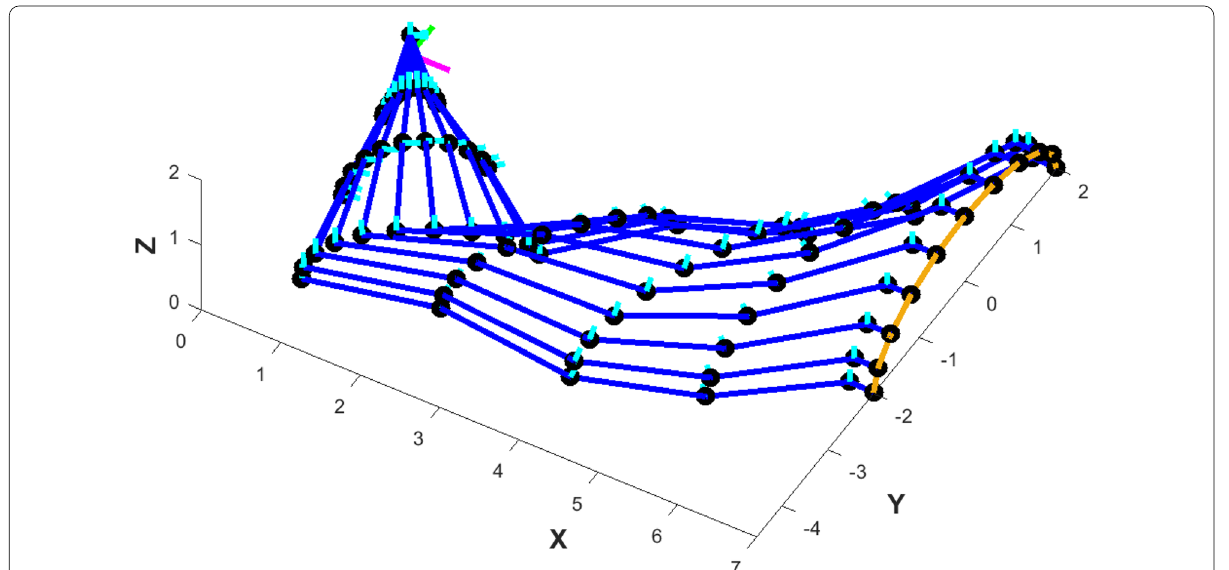
Fig. 9 The sequence of arm configurations in the object manipulation mission